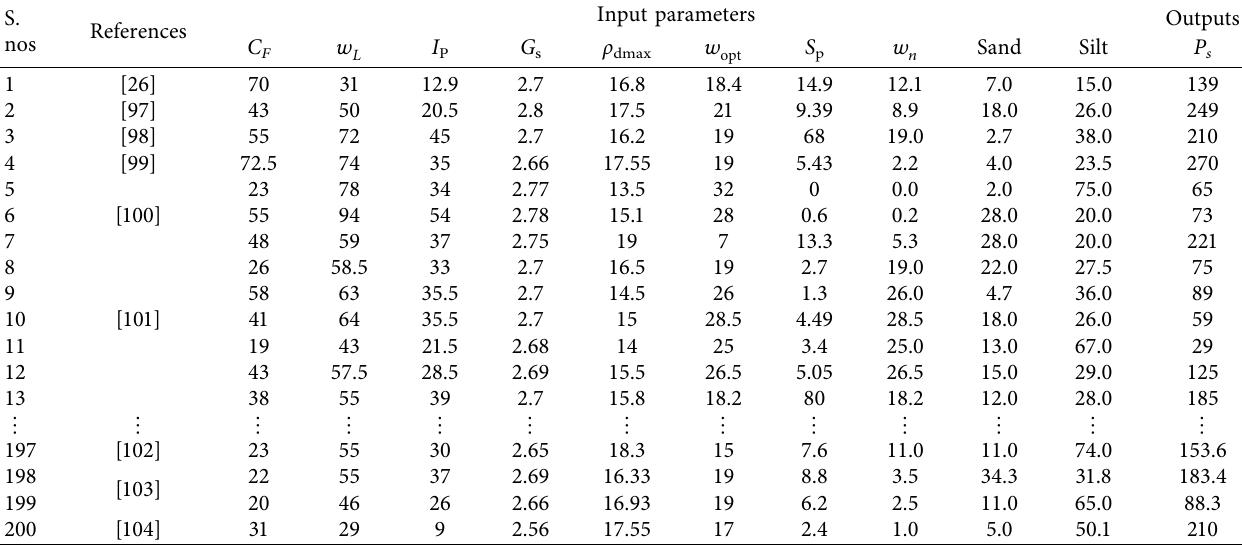
Table 2: Experimental database of the input parameters and output parameter collected from the past literature. S.